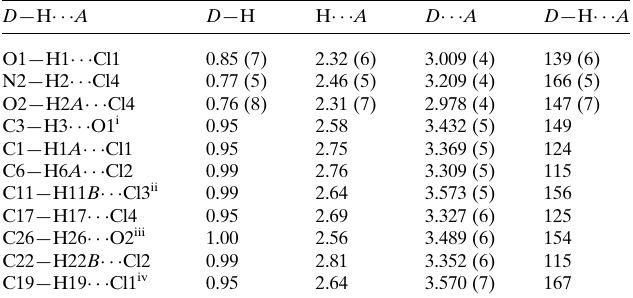
Table 1 Hydrogen-bond geometry (A˚ , (cid:2) ).